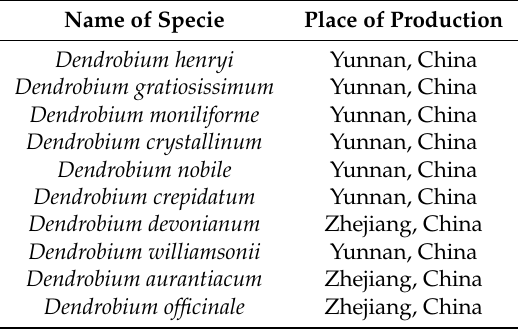
Table 1. Details of the dendrobium